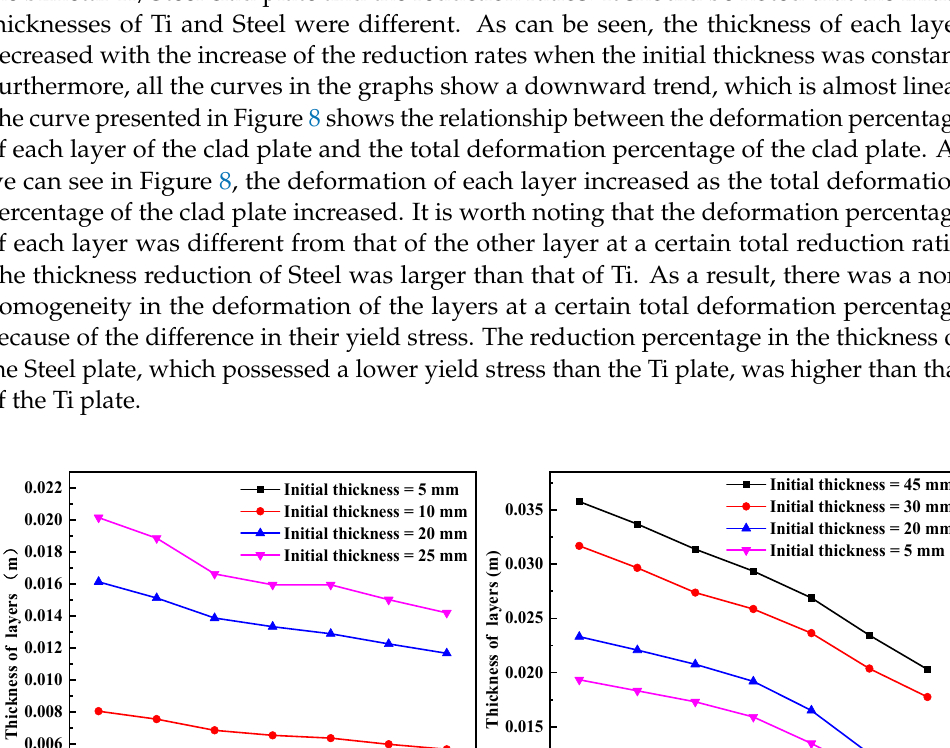
Figure 6. Changes in rolling force vs. reduction ratio of the clad plate.